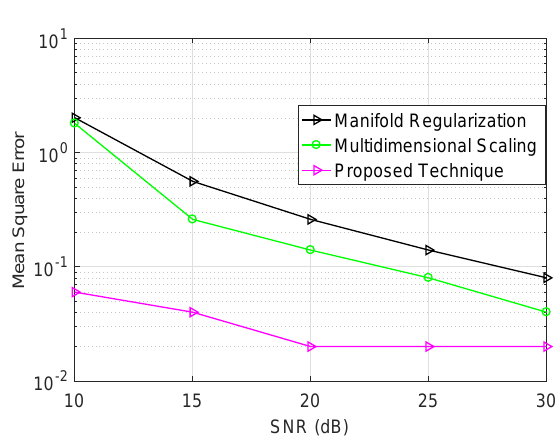
Figure 7. Efficiency vs. energy harvested.